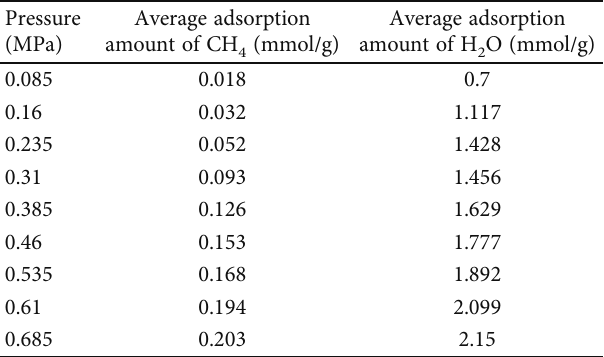
Figure 7: Two-component isothermal adsorption curve at 303.15K. Table 8: Adsorption amount of methane and water at 0.01 – 0.76MPa for two-component